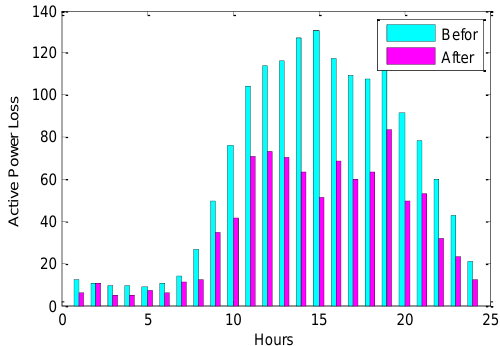
Figure 18. Active power losses for 24 h (second scenario).